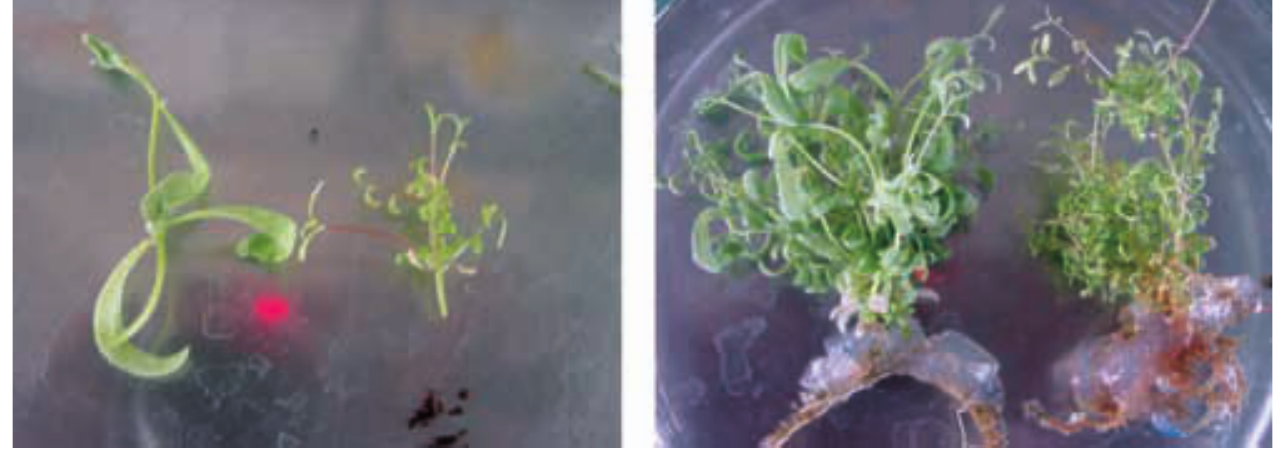
Fig. 7. Effect of NaCl on the growth and size of the leaves in vitro of A. halimus L. Left : shoots grown on medium 5 with 200 mM NaCl. Right : Control: shoots grown on medium free of